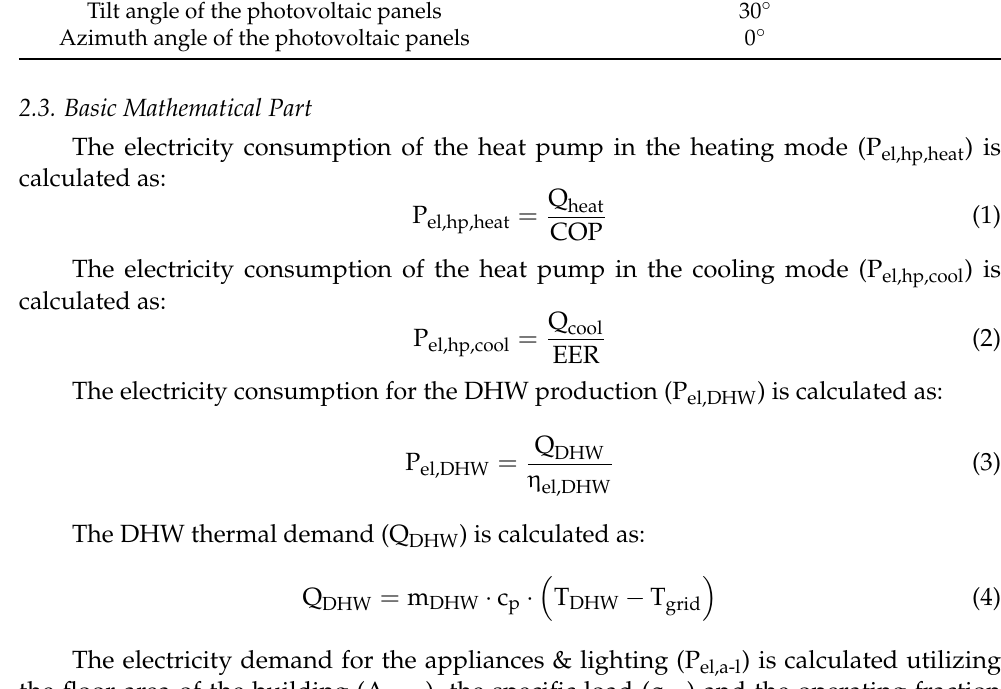
Tilt angle of the photovoltaic